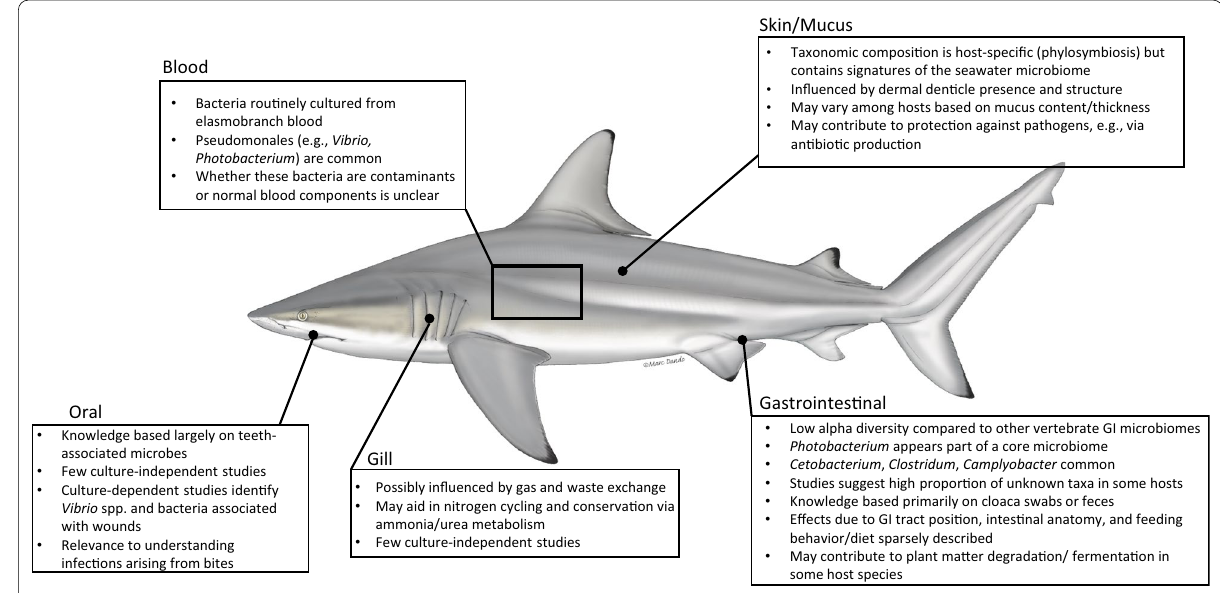
Fig. 4 Microbiomes differ among elasmobranch body niches. (Marc Dando, Wildlife